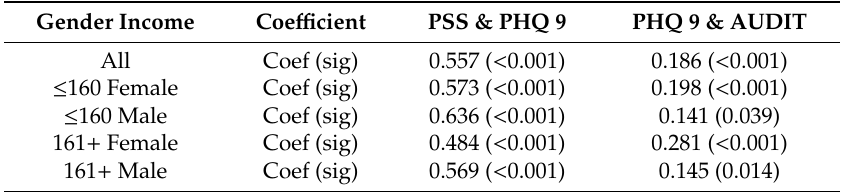
Table 7. Spearman correlation ( (cid:37) )